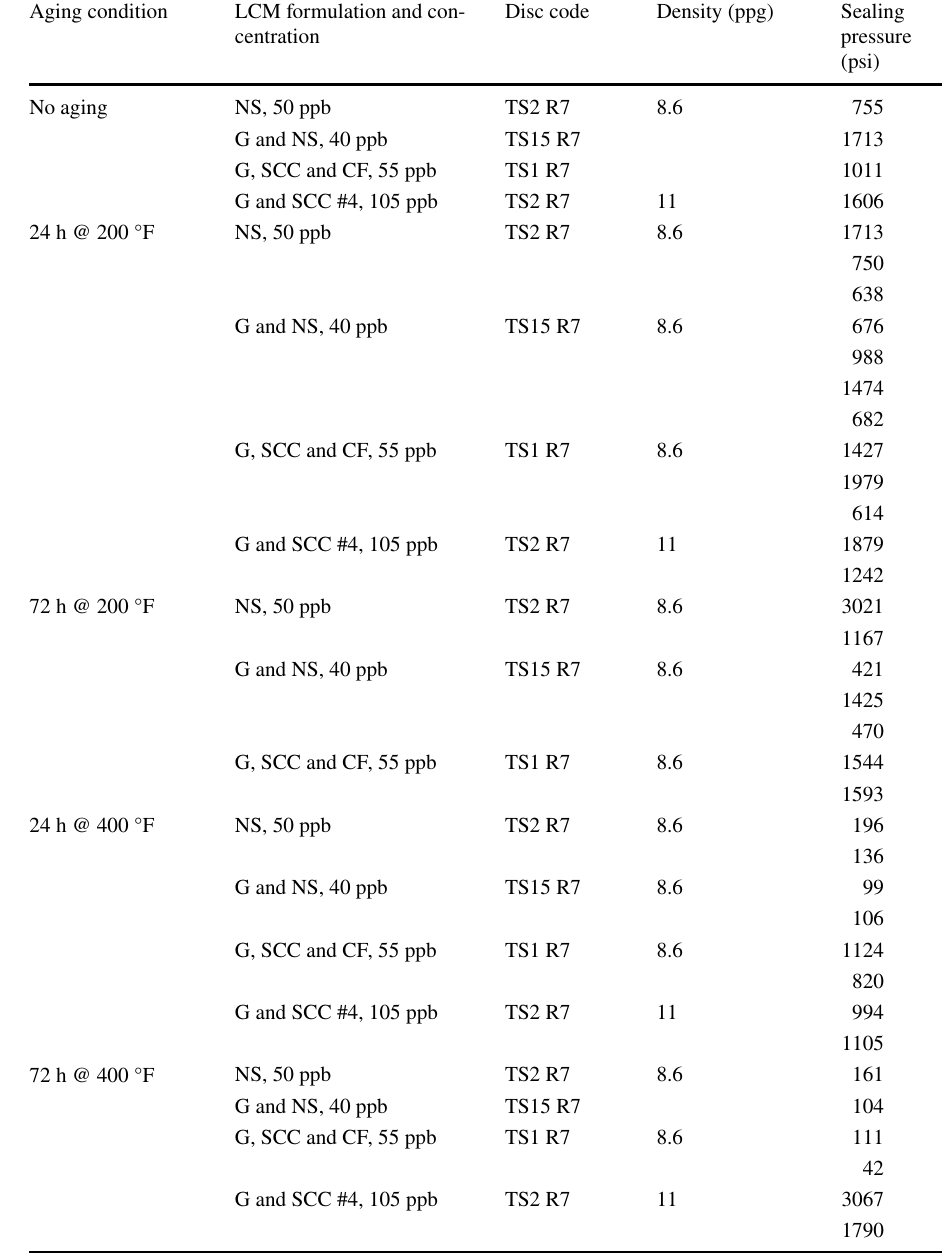
Table 5 Aging condition testing